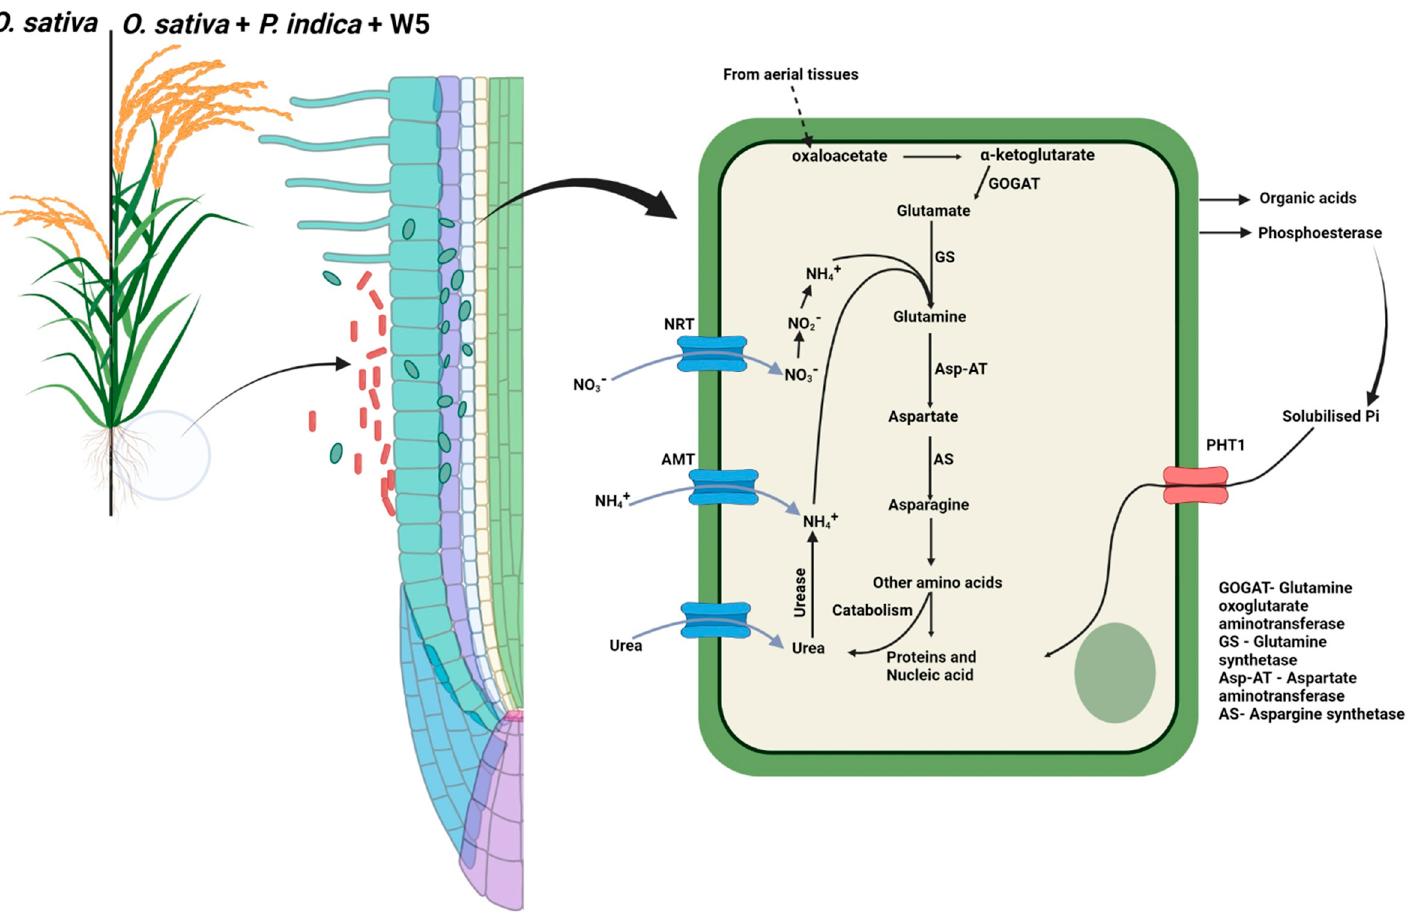
Figure 7. Hypothetical model for explaining the mechanism of nutrient uptake that promotes higher plant growth and biomass in the presence of endophytic fungus P. indica and plant growth-promoting rhizobacterium A. chroococcum strain W5.